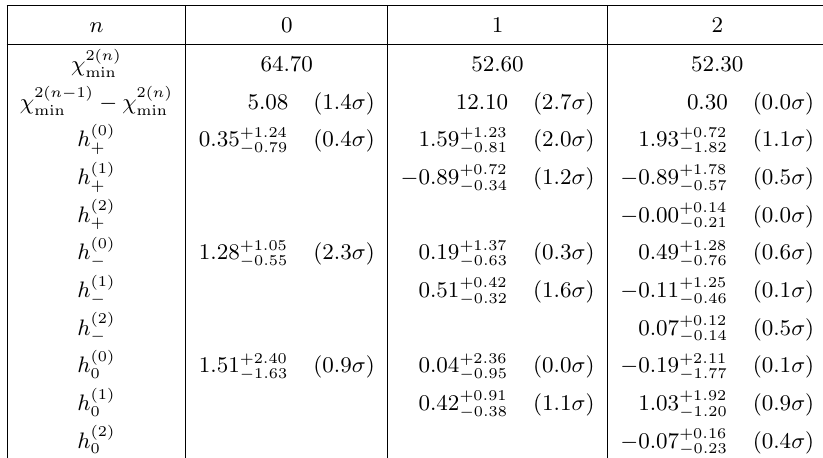
Table 5 . Fit to B ! K (cid:3) (cid:22) + (cid:22) (cid:0) only, with C (cid:22); NP = 0, using LCSR results from ref. [18] in the 9 full-form-factor approach. All coe(cid:14)cients are given in units of 10 (cid:0) 4 . Di(cid:11)erent orders n of the polynomial parametrisation of the long-distance charm-loop contribution are considered. If this contribution is set to zero, the (cid:12)t yields (cid:31) 2 = 69 : 80 for N dof = 59. min; h =0